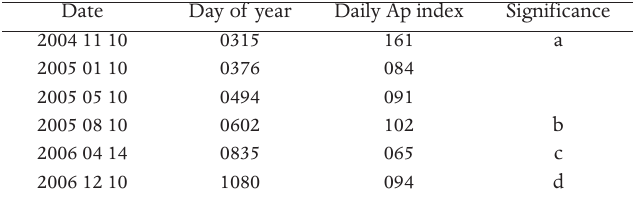
Table 3. Daily Ap-index linked to the geomagnetic